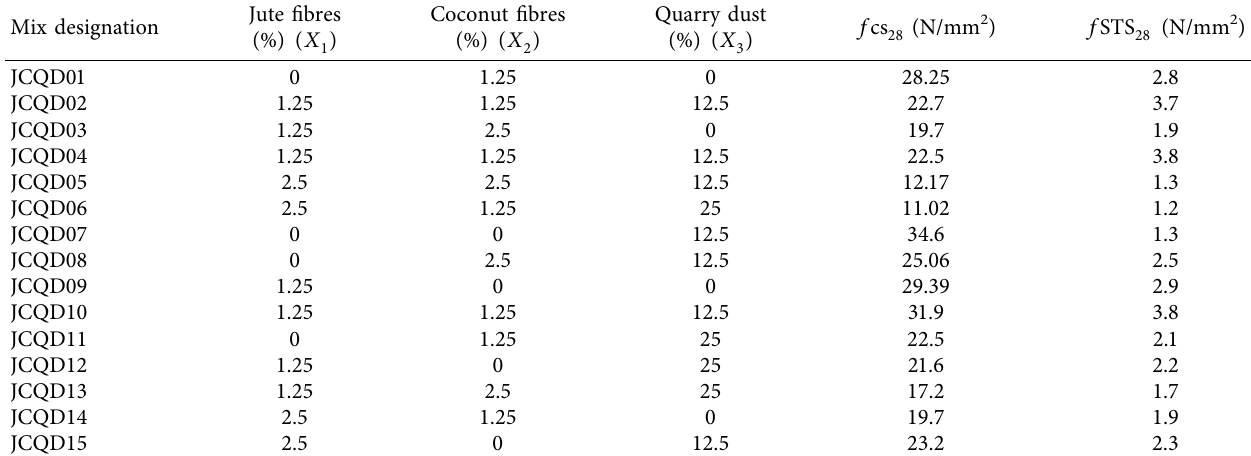
Table 3: Predicted strengths.